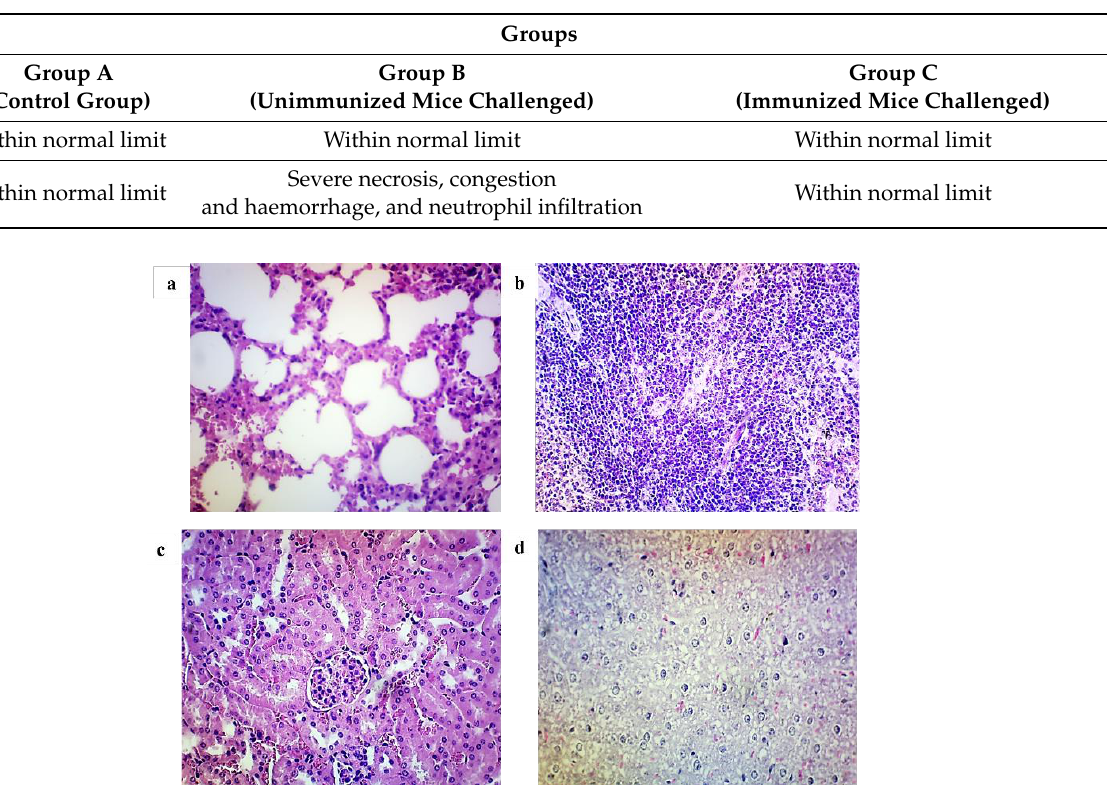
Figure 8. Histopathology changes in the lung ( a ), spleen ( b ), kidney ( c ), and liver ( d ) of immunised mice in Group C after ETEC challenge (H and E, ×400). ( a ) Section from a lung shows mild lymphocytic infiltration, congestion, and oedema of the interstitium with focal alveoli oedema and type II pneumocytes hyperplasia. ( b ) Section from the spleen shows mild focal parenchymal congestion and focal apoptosis. ( c ) Section from a kidney shows mild degeneration of tubules, congestion, and inflammation of the interstitium. ( d ) Section from the liver shows mild degeneration of hepatocytes, sinusoidal congestion, Kupfer cell hyperplasia, and portal inflammation.